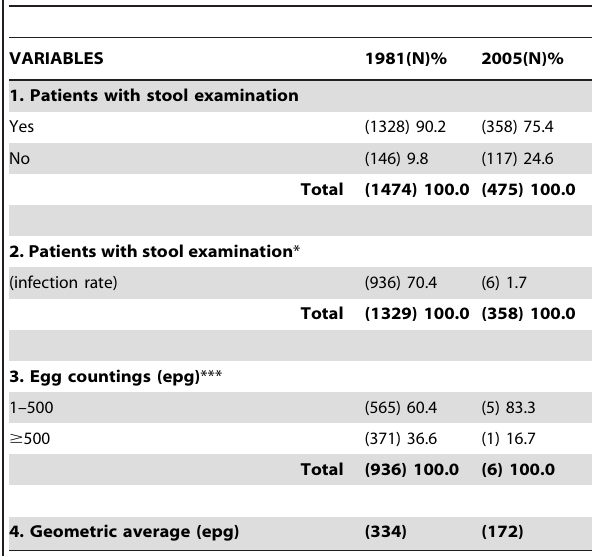
Table 2. Distribution of schistosomiasis indicators in patients living in Comercinho/MG, Brazil (1981–2005).